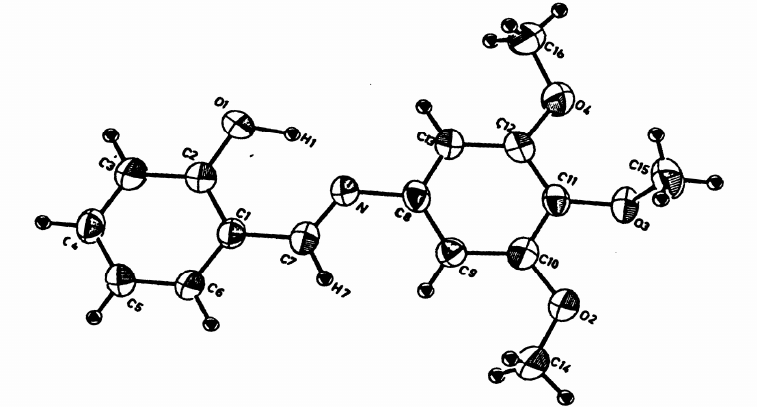
Figure 1. Molecular structure of 3,4,5-trimethoxy N -(2-hydroxybenzylidene) aniline with atomic numbering scheme. ( Displacement ellipsoids are drawn at 50% probability level